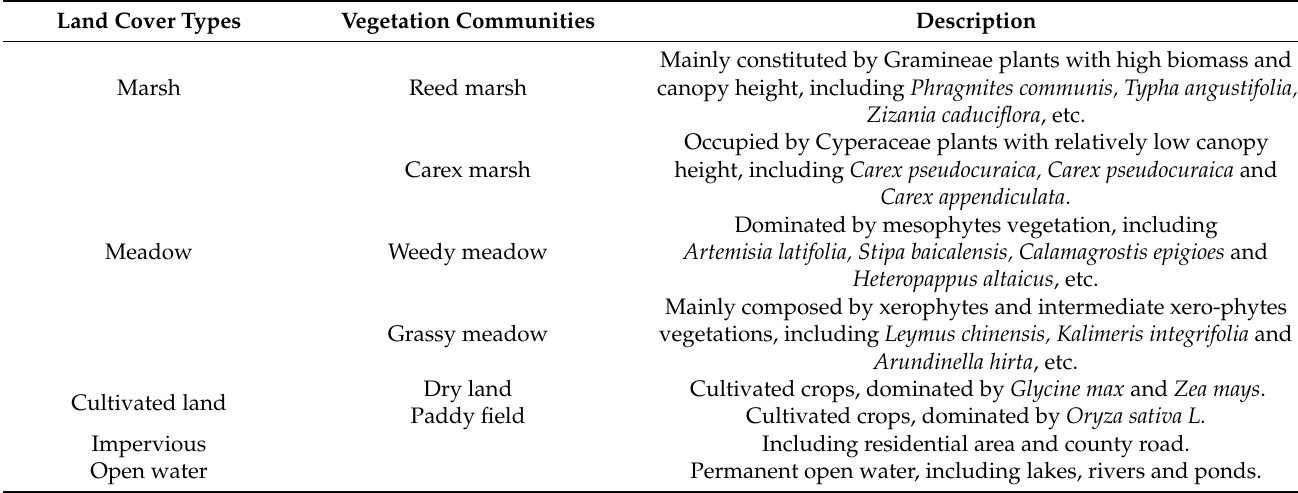
Table 1. The description of different land covers in the Zhalong